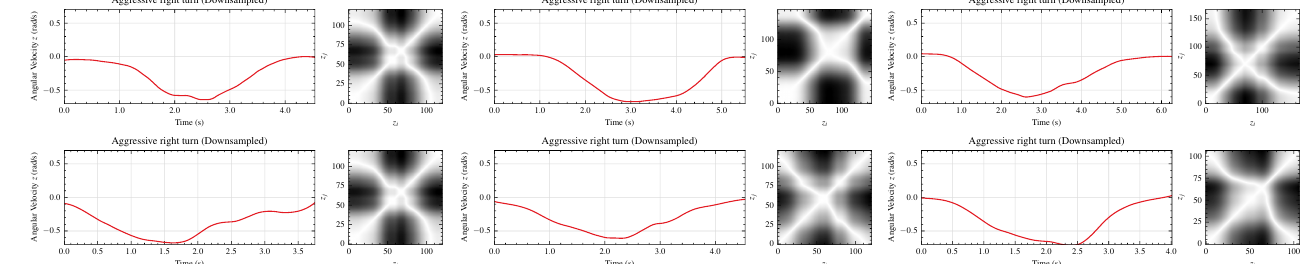
Figure 8. Time series and recurrence plots (on the right side of each driving event) of the angular velocity signal in the z direction for six different aggressive right turn